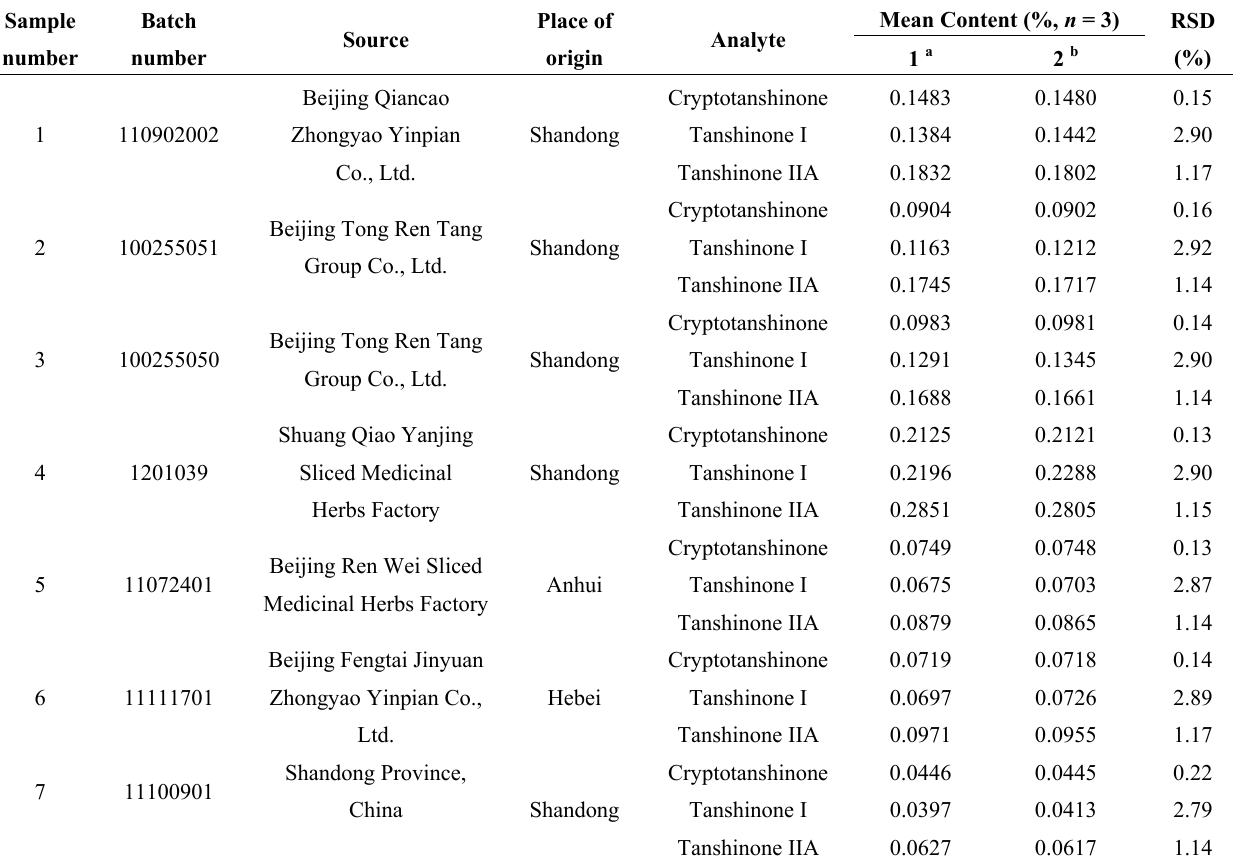
Table 8. Contents of the three compounds in S. miltiorrhiza Bunge as determined using reference extractive and standards.